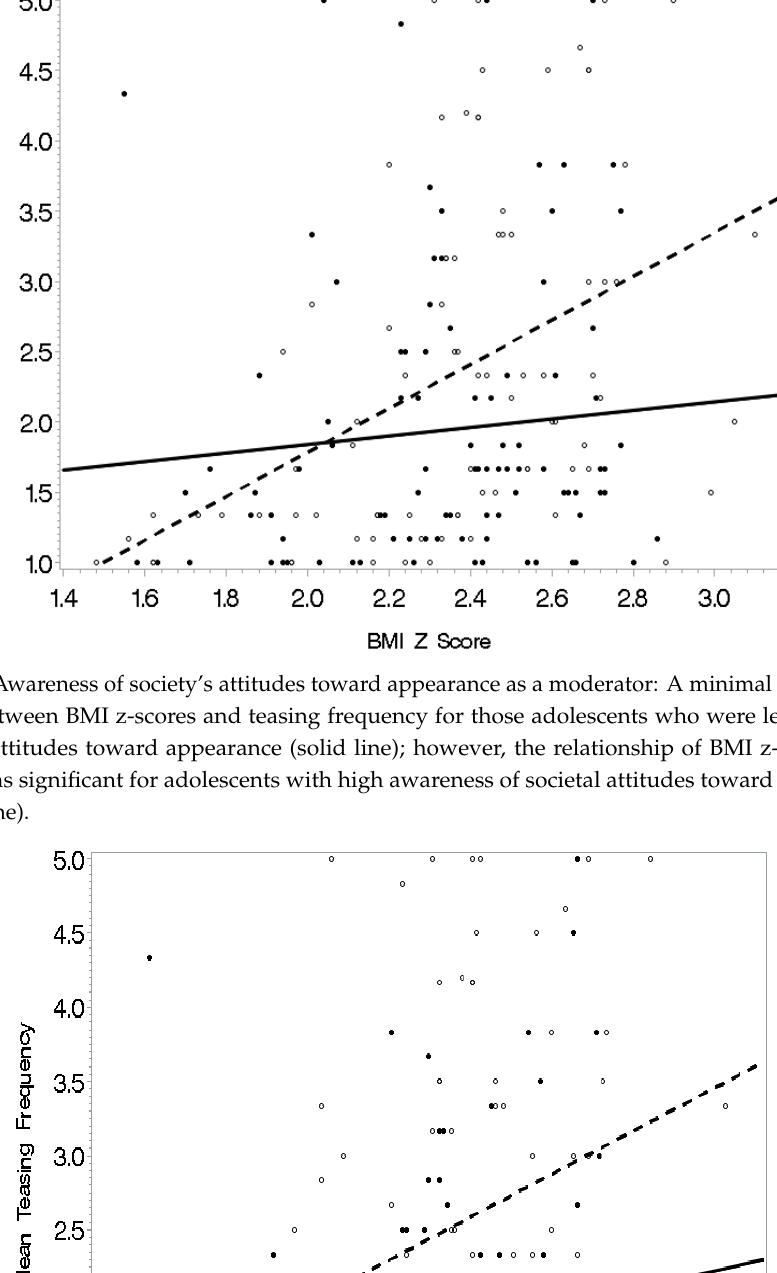
Figure 3. Internalization of society’s attitudes toward appearance as a moderator: The relationship between BMI z-scores and teasing was less strong for adolescents who did not aspire to society’s standards for attractiveness (solid line) as compared to those who internalized those attitudes (dashed line).